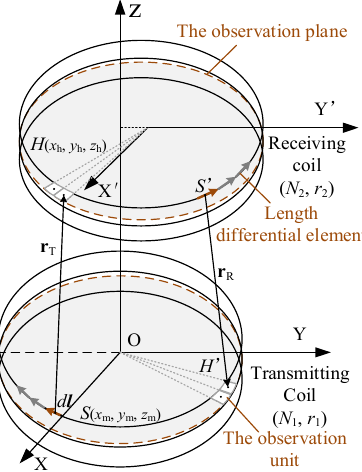
Figure 2. The magnetic field analysis model of the resonant coils.